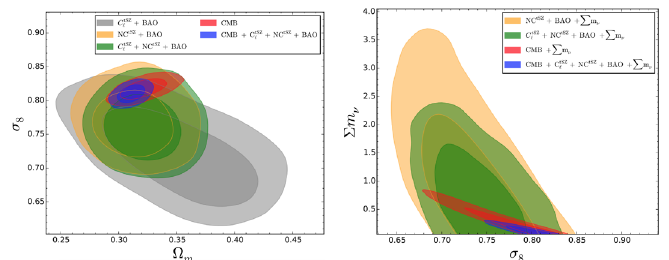
Figure 1. Two-dimensional probability distributions m ν for for Ω m , σ 8 and di ff erent dataset (cid:31) combinations, as discussed in the text. These plots are taken from